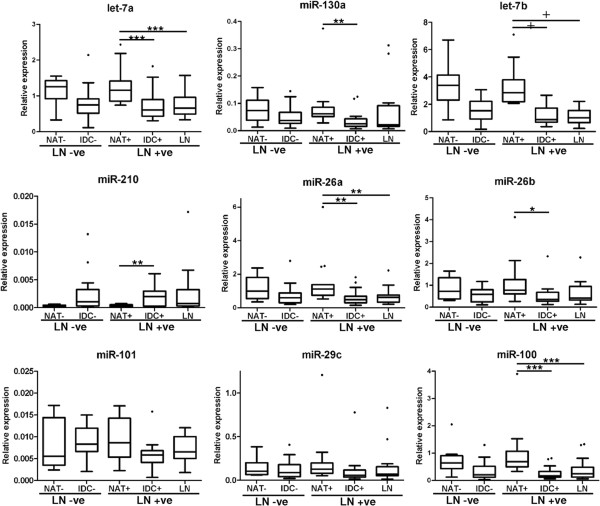
Validation of selected miRNAs significantly different in triple negative breast cancer with lymph node metastases. Relative quantification of let-7b, miR-130a, miR-101, miR-26a, miR-100, miR-210, miR-26b, miR-29c and let-7a by real-time RT-PCR in normal and tumour samples from lymph node negative and lymph node positive patients. Results are shown as a box plot of the relative normalised expression (target/RNU44) of the target miRNA (2-ΔCt). Boxes represent the median ± interquartile range. *p < 0.05, **p < 0.01, ***p < 0.0005 and +p < 0.0001.